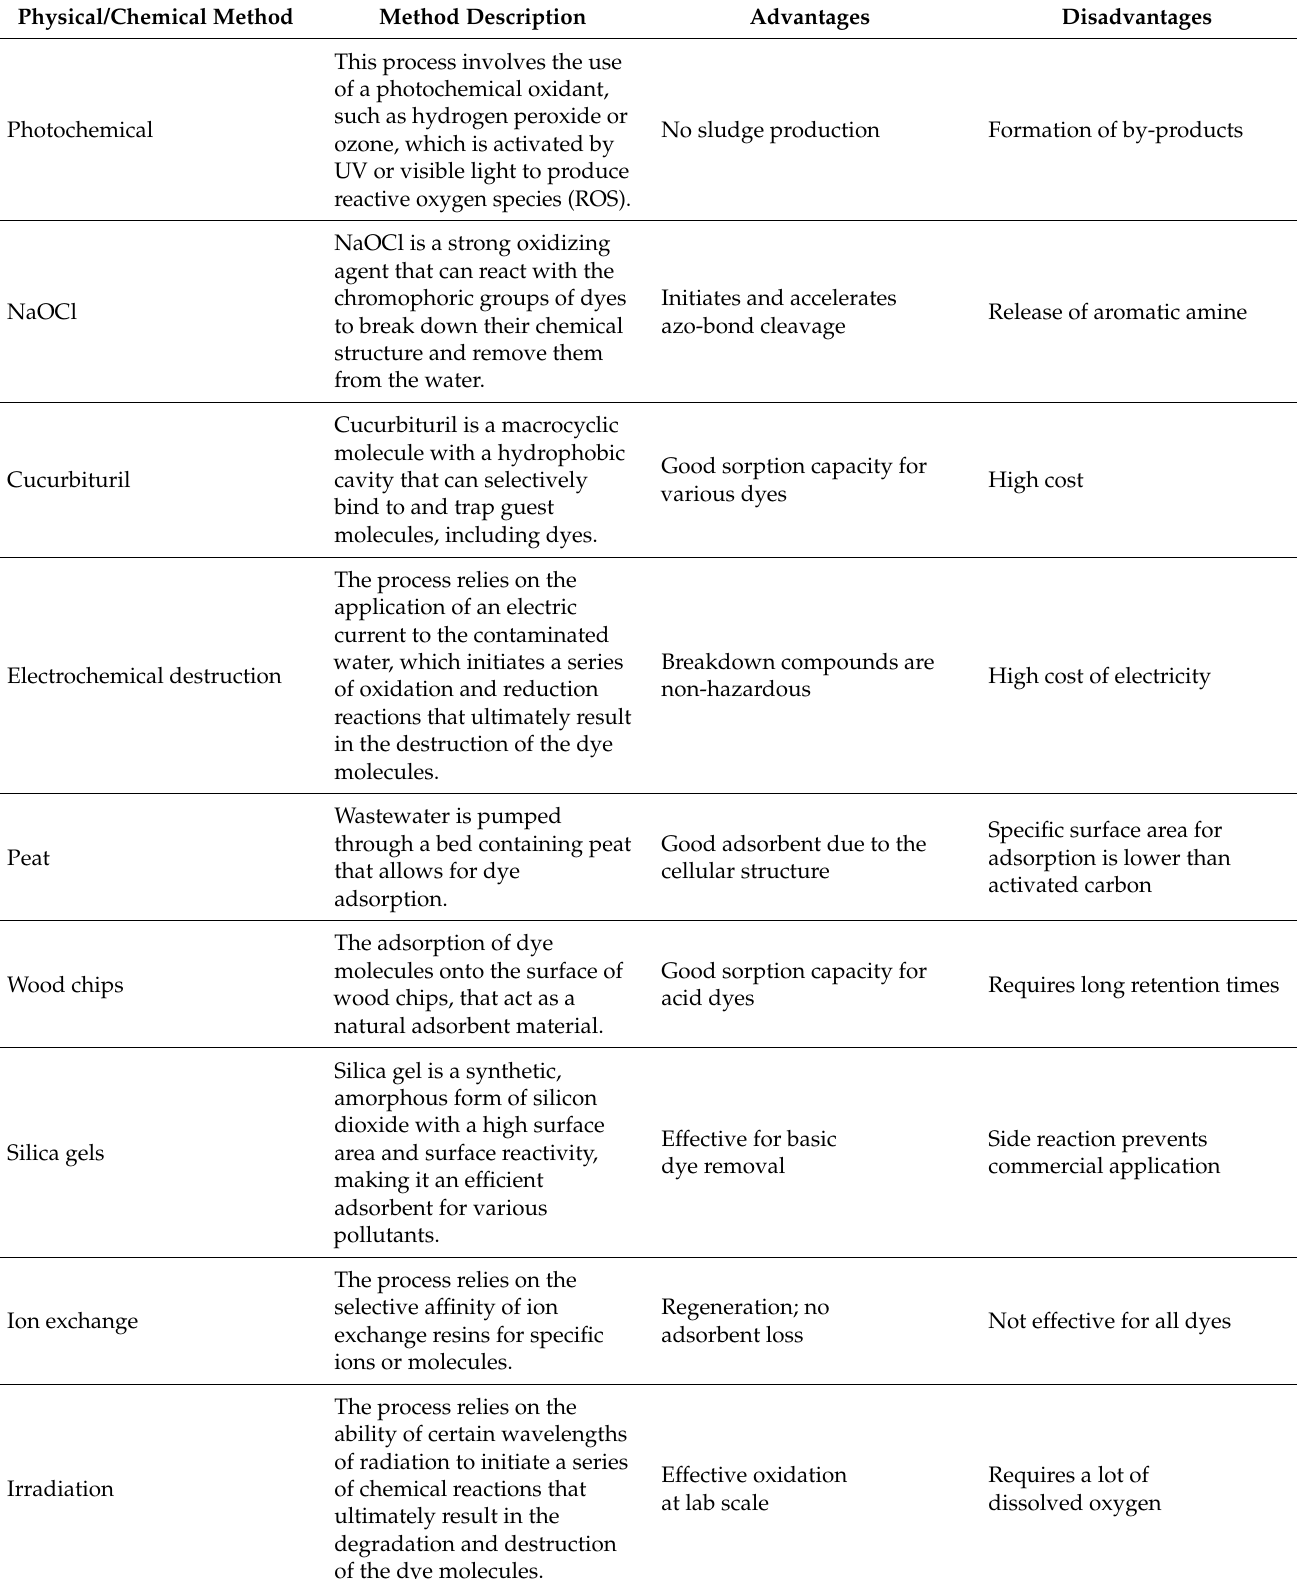
Table 7. Advantages and disadvantages of other physical and chemical alternative methods for dye removal in textile